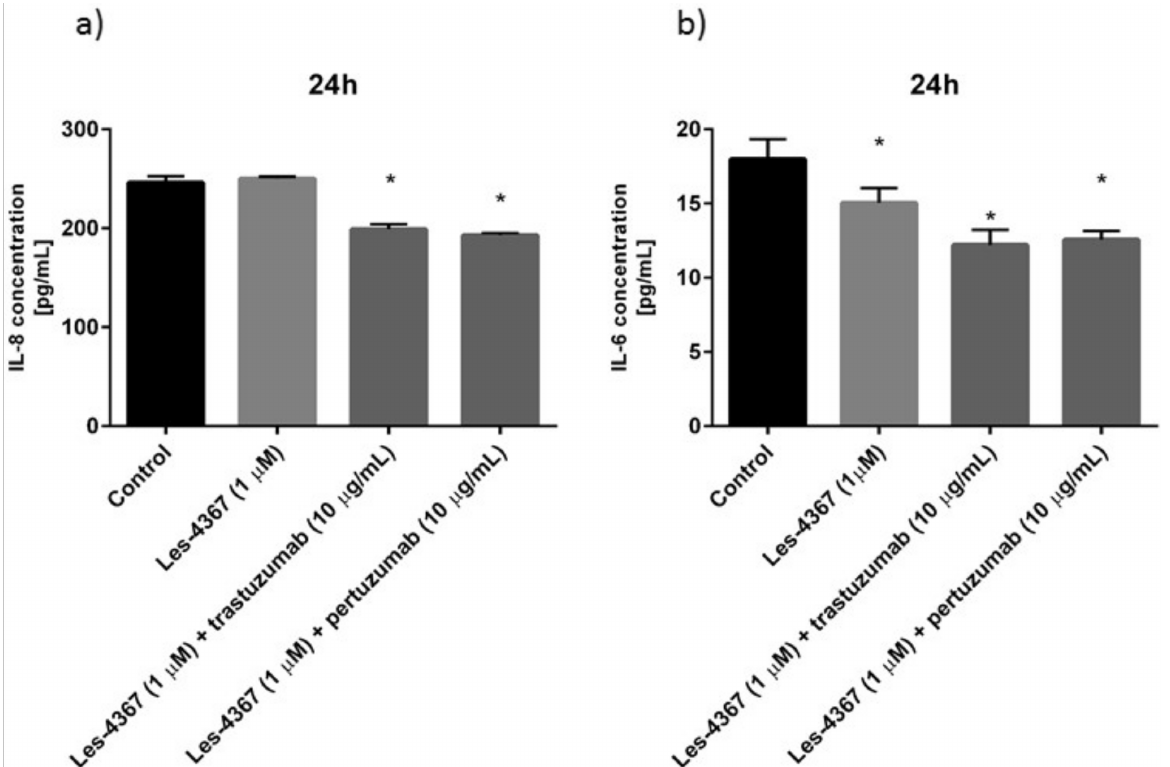
Figure 11. Concentration of pro-inflammatory IL-8 ( a ) and IL-6 ( b ) in AGS cells after 24 h incubation with Les-4367 (1 µ M) and combined with anti-HER2 antibodies. The ANOVA and Tukey tests were used to demonstrate differences between the control cells and the cells exposed to varying concentrations of the tested compounds. * p ≤ 0.05 vs. control